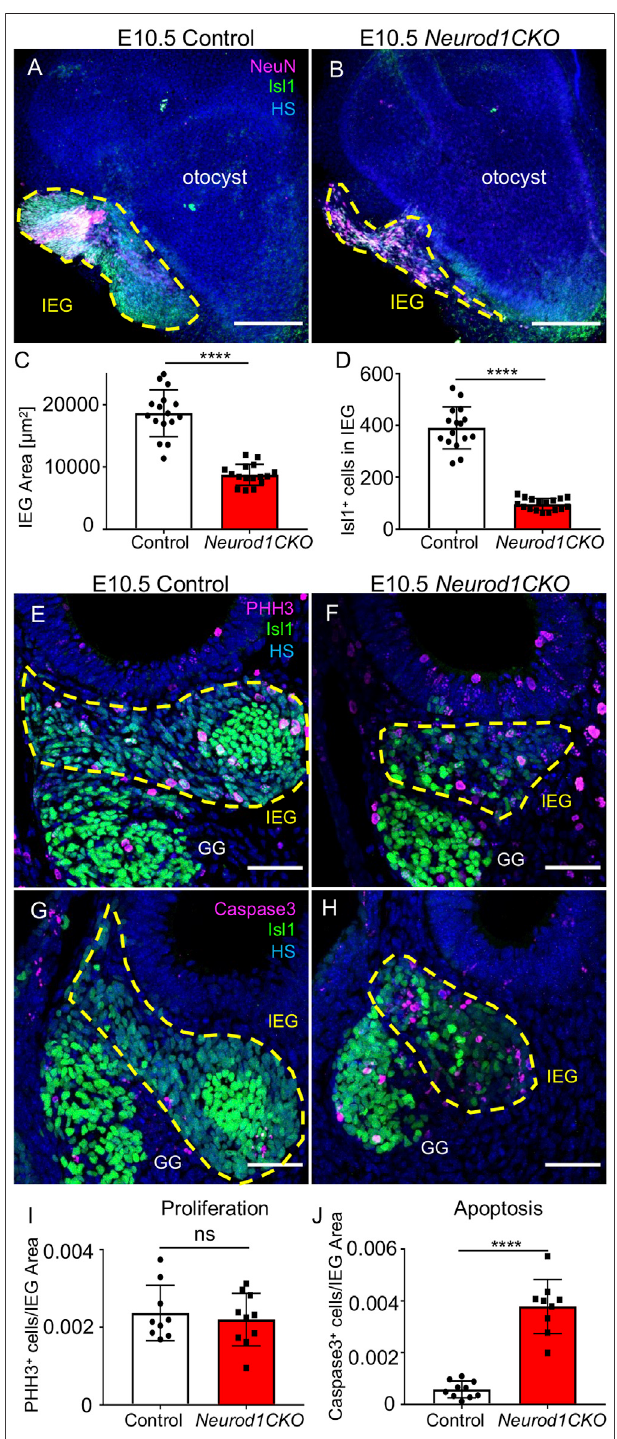
FIGURE 4 | Diminished inner ear ganglion and massive apoptosis are detected in Neurod1CKO at E10.5. (A , B) Representative whole-mount immunolabeling of the otocyst shows the size of otic ganglia (dotted line area) with anti-Isl1 and anti-NeuN (a nuclear marker of neurons). (C , D) Quanti fi cation of the ganglion size and number of ISL1 + neurons in the inner ear ganglion. The values represent mean ± SD, t -test, **** p ≤ 0.0001 ( n = 10